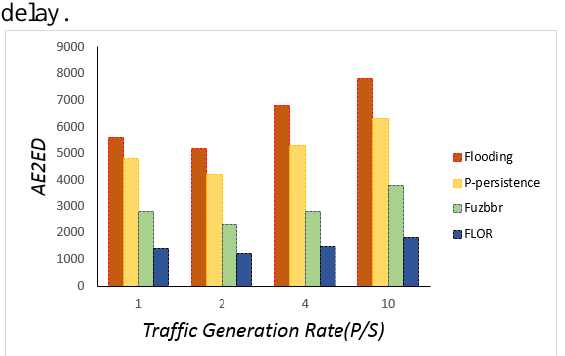
Figure 13. Average end-to-end delay for different traffic generation